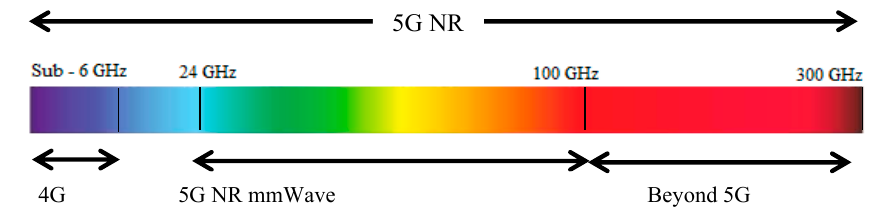
Figure 5. High-spectrum access (mmWave).